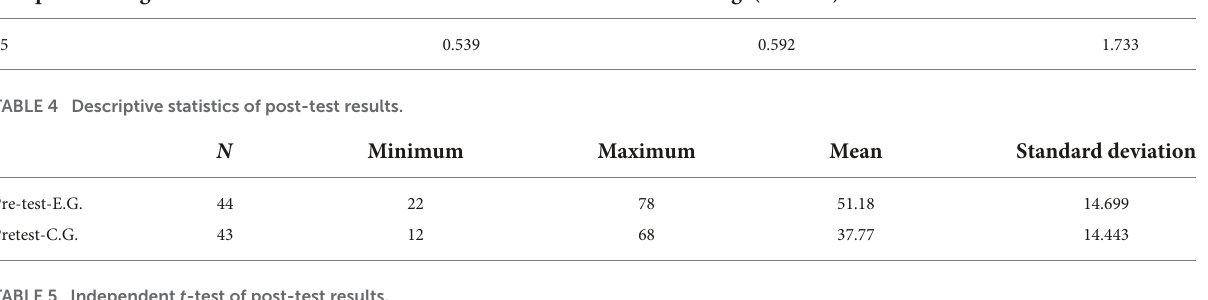
TABLE 5 Independent t -test of post-test results.